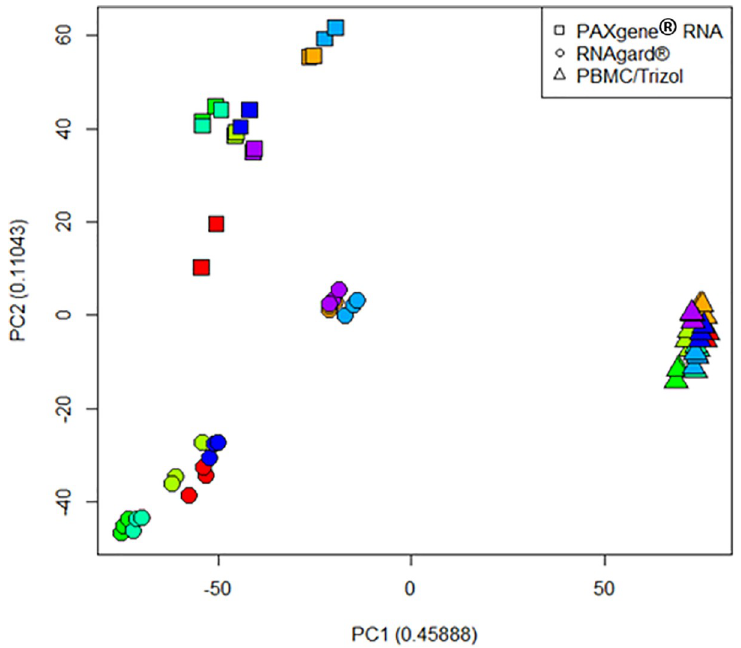
Fig 2. Principal component analysis of technical replicates. Principal Component Analysis (PCA) of normalized mRNA transcript values across individuals (colors) and platforms.